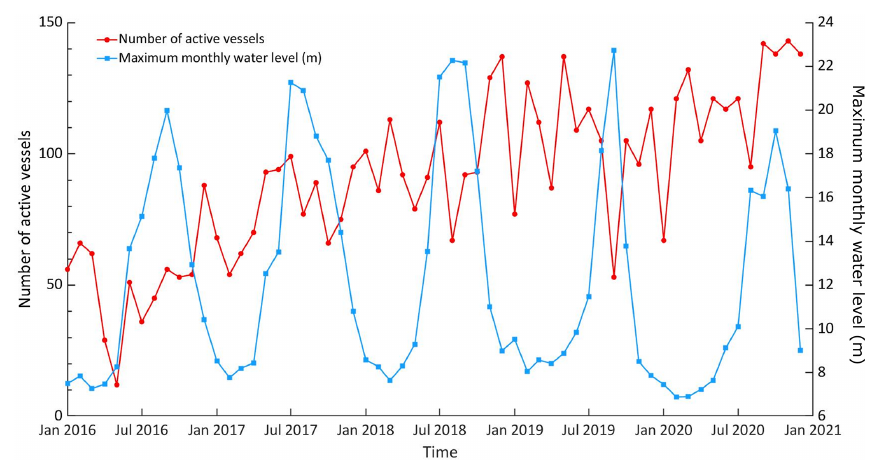
Figure 3. The number of active vessels (vessels greater than 100m from the riverbank) identified in each monthly composite image over the period January 2016 to December 2020 (red) and the maximum water level (m) at Kratie in each month over the same period, highlighting that higher water levels are associated with reduced river vessel traffic due to difficult navigation conditions and faster-flowing water in monsoon periods.